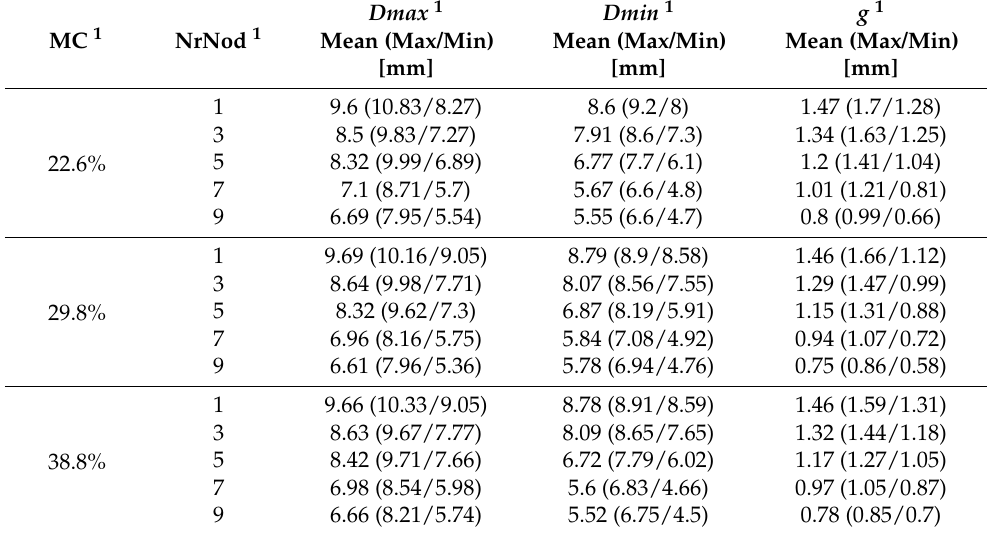
Table 3. Dimensions of the miscanthus stalk samples’ cross-section used for three-point bending tests along the